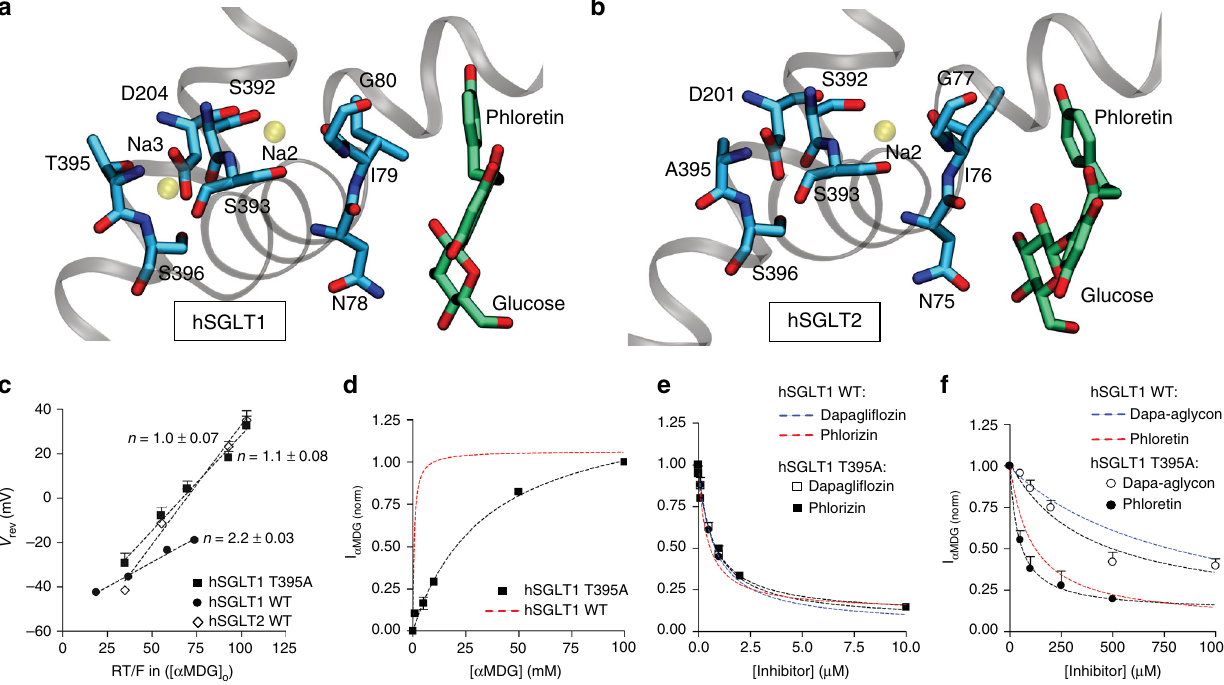
Fig. 4 Allosteric communication between sodium and substrate sites. a The hSGLT1 – phlorizin model shows the location of Na + (transparent yellow) in the Na2 site over 8 Å from the inhibitor and the putative Na3 site 14Å away. The Na2 Na + interacts with the side chains of S392 and S393 and the carbonyl backbone of I79, while the ion at Na3 is stabilized by backbone carbonyls, side chains of T395 and S396, and bidentate interaction with D204. b The hSGLT2 – phlorizin model shows the location of the conserved Na2 binding site (transparent yellow), but the putative Na3 site is lost by the hydrophobic substitution A395. c hSGLT1 T395A and wild-type hSGLT1 and hSGLT2 stoichiometries were determined from the reversal potential ( V rev ). The inverse of the slope, Na + -to-glucose coupling ratio, n , is 1-to-1 Na + -to-substrate stoichiometry for the hSGLT2 wild-type and the T395A hSGLT1 mutant and 2-to-1 for wild-type hSGLT1. d α MDG dependence of hSGLT1 T395A (black squares) sugar current in injected oocytes. K 0.5 = 34±4 mM compared to K 0.5 = 0.9±0.1 mM for wild type. Data in d – f are normalized to the current measured in 10 mM α MDG without inhibitors, and the red dashed curves are representative, wild-type hSGLT1 responses. e Phlorizin (black squares) and dapagli fl ozin (open squares) effect on α MDG currents for hSGLT1 T395A in 30 mM α MDG. For hSGLT1 T395A K i = 0.35± 0.10 and 0.4± 0.1 µ M for phlorizin and dapagli fl ozin, respectively, while wild type estimated K i = 0.22 ±0.04 and 0.45±0.02 µ M for phlorizin and dapagli fl ozin, respectively. f Phloretin (black circles) and dapa-aglycon (open circles) effect on α MDG currents for hSGLT1 T395A in 30 mM α MDG. For hSGLT1 T395A K = 20±7 and 187± 80 µ M for phloretin and dapa-aglycon, respectively, while the wild-type K = 55± 12 and 425± 50 µ M for i i phloretin and dapa-aglycon, respectively. Each data point is the mean ±SEM of n = 10 oocytes ( c ), n ≥ 5 oocytes ( d ), and n ≥ 7 oocytes ( e , f